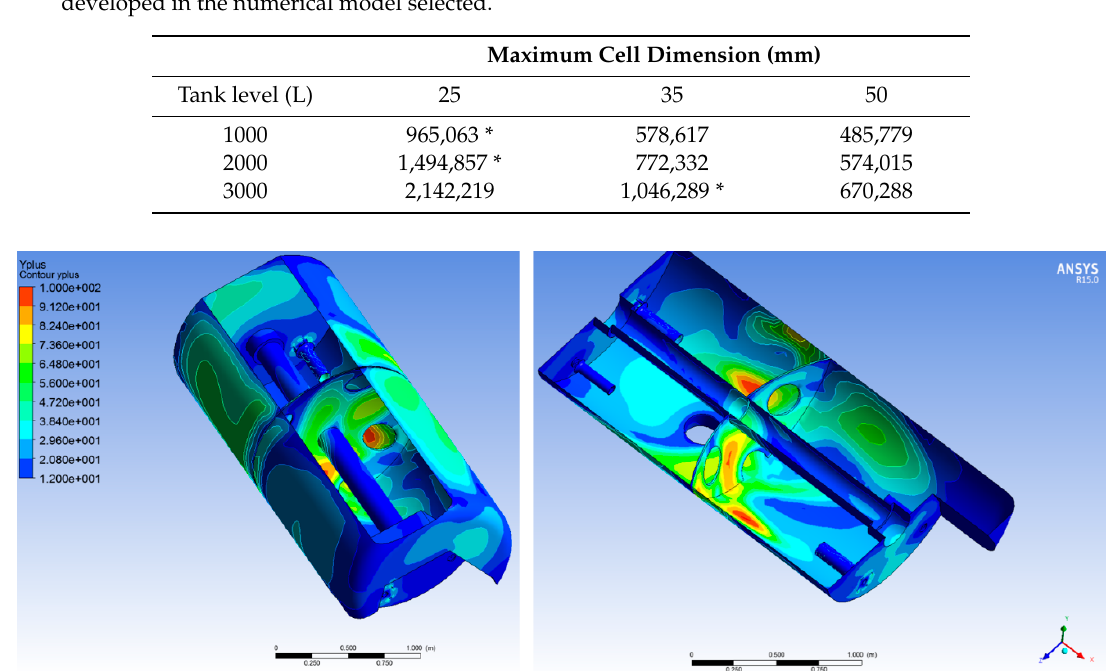
Figure 4. Contours of y + in the tank with ( left ) 3000 and ( right ) 1000 L, with two nozzles in use and 10 bar pressure.